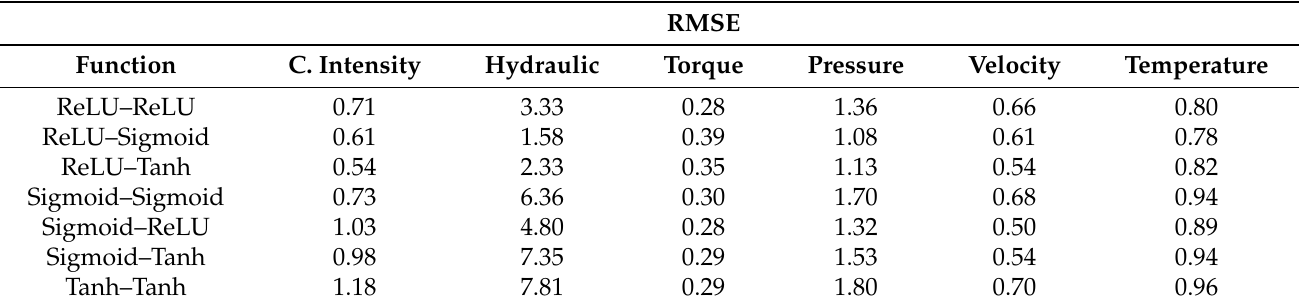
Table 7. Average RMSE obtained for the six variables after the average clean method, with different activation functions using the GRU model.